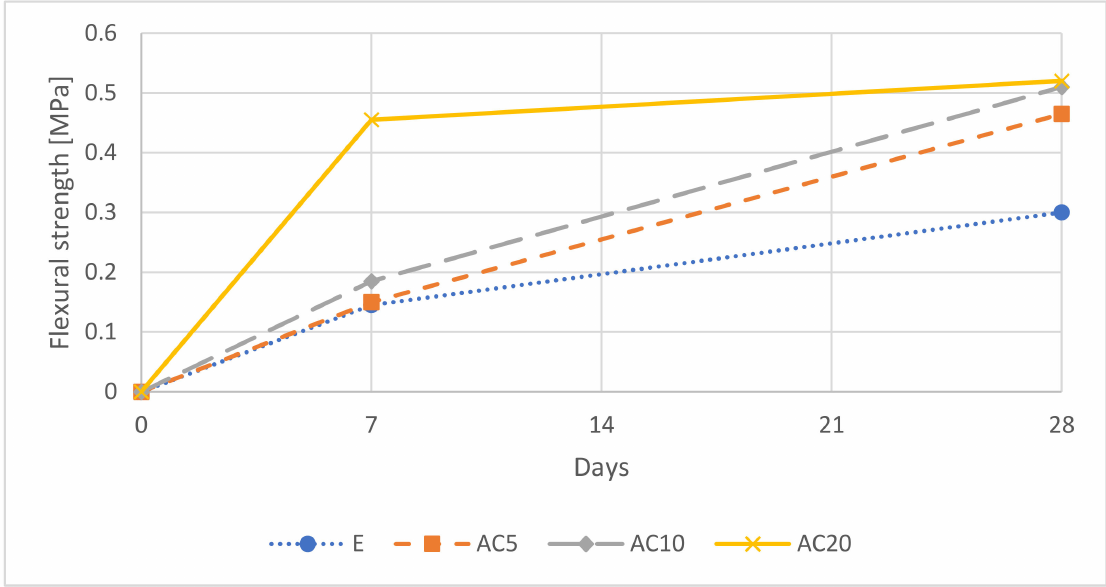
Figure 7. Development of flexural strength from 7–28 days in Series 3 (varied w/b ratio and percentage of WPC, 0.4% AEG agents